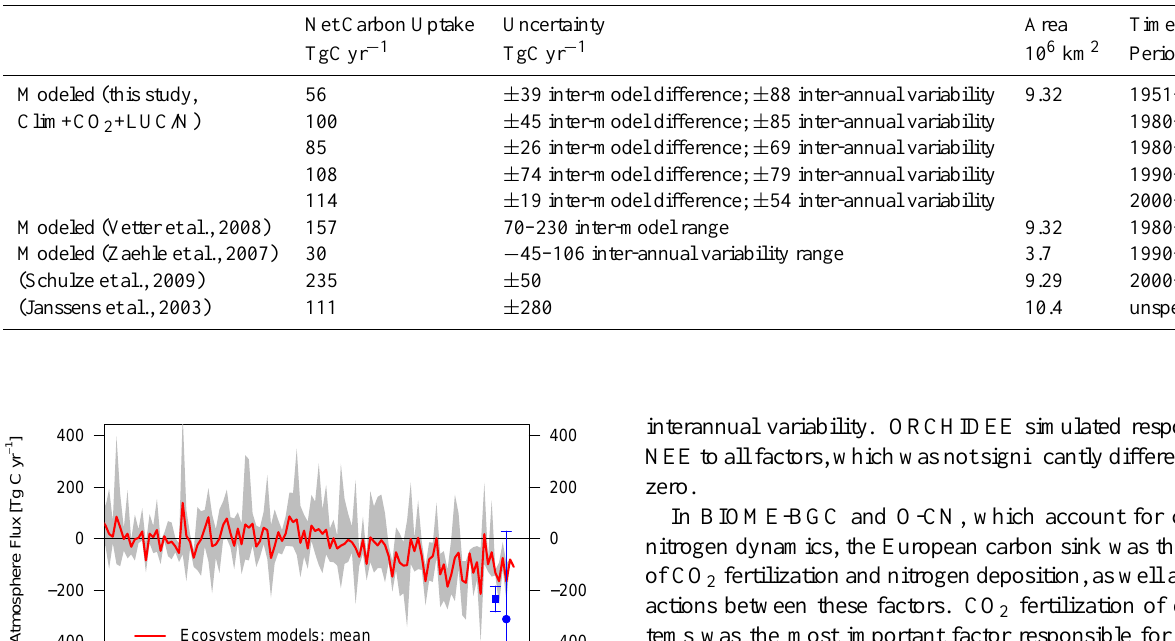
Table 3. Mean carbon balance of Europe from different land-based data compilation and model simulations. The inter-model uncertainty is quantified as the standard deviation of the modeled average carbon uptake for a given period. The inter-annual variability is the inter-model mean of the variability of the annual means for each model.